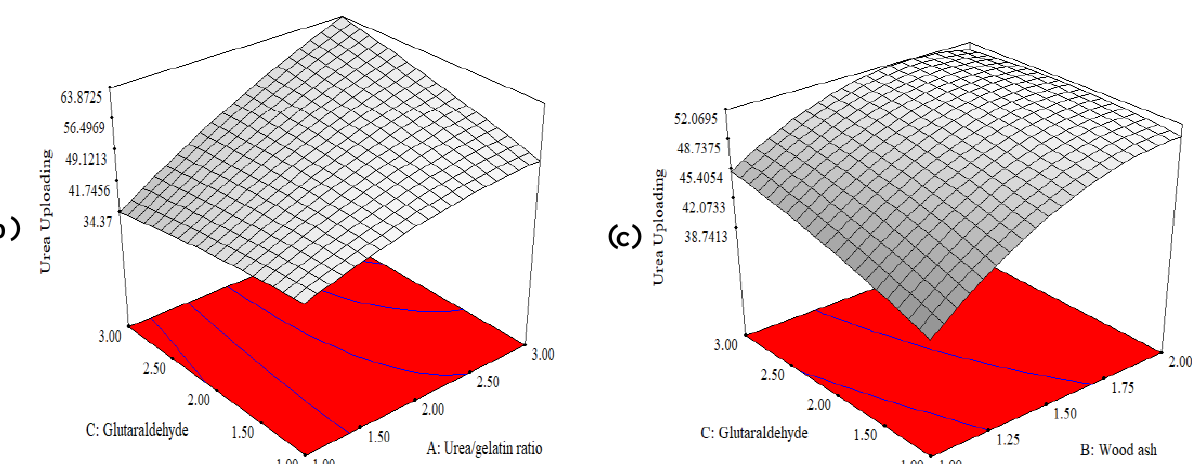
Figure 10. The effect of independent variables on urea uploading is shown in a three-dimensional response surface graphic. ( a ) The interaction between the urea/gelatin ratio and the amount of wood ash at a GA concentration of 2 mL g − 1 ; ( b ) The interaction between the urea/gelatin ratio and the amount of wood ash at 1.5 g; ( c ) The interaction between the amount of wood ash and GA at a 2:1 urea/gelatin ratio.